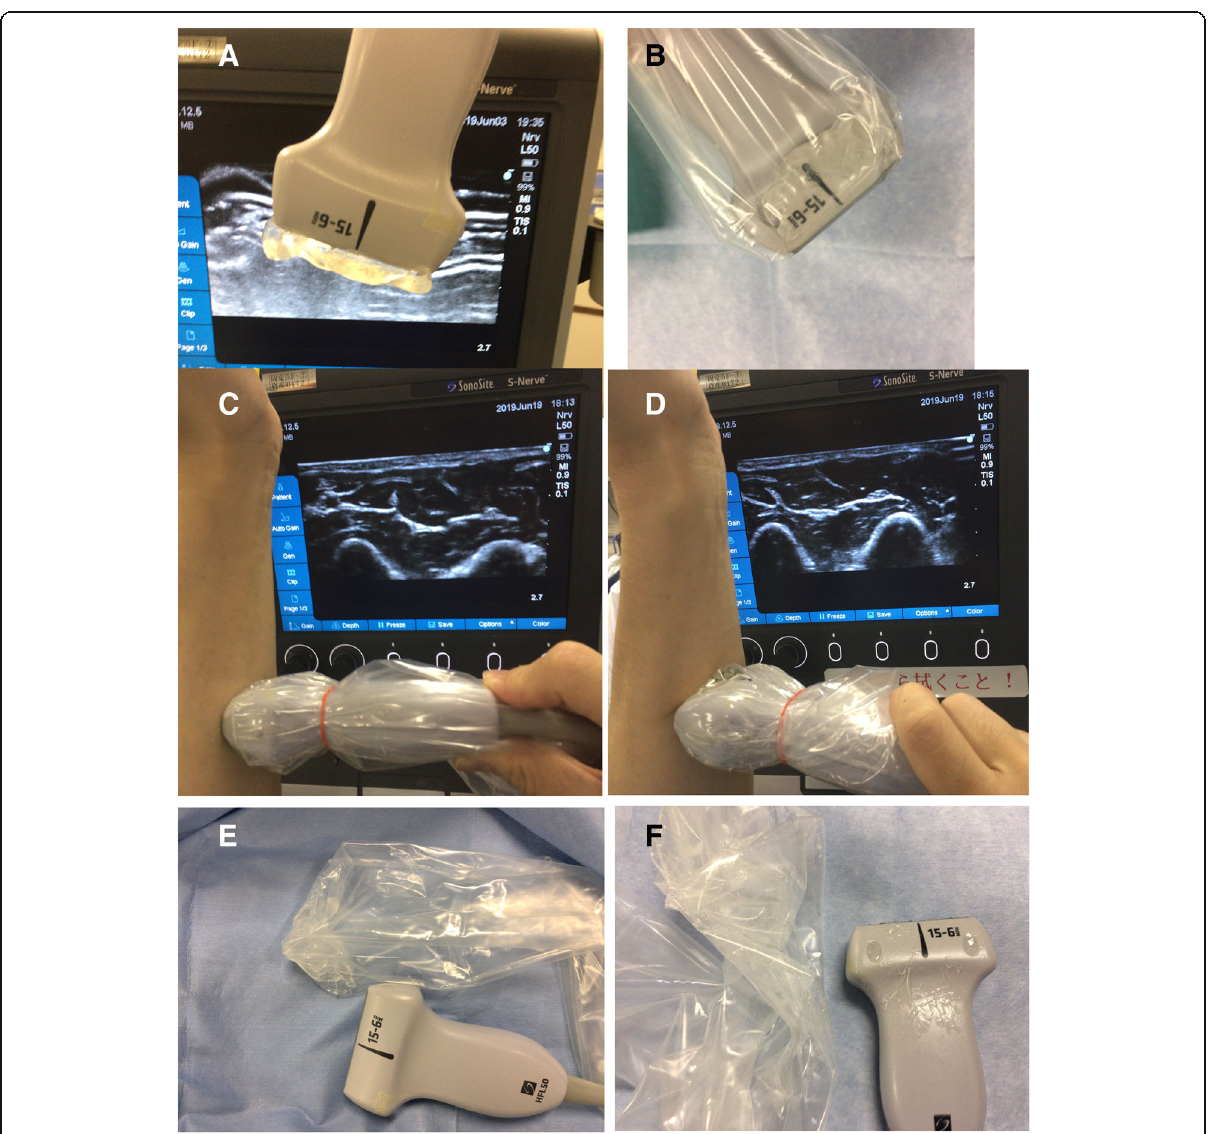
Fig. 1 a Simple application of SLIME on the probe allows the SLIME to be placed firmly on the probe. b Application of SLIME on the probe allows entry of air between the probe and probe cover to be avoided. c The ultrasound image of the median nerve at the forearm obtained with the use of SLIME on the probe. d The ultrasound image with the use of water-soluble gel. e The probe remains smooth after removal of the probe cover using SLIME. f The probe after removal of the probe cover using